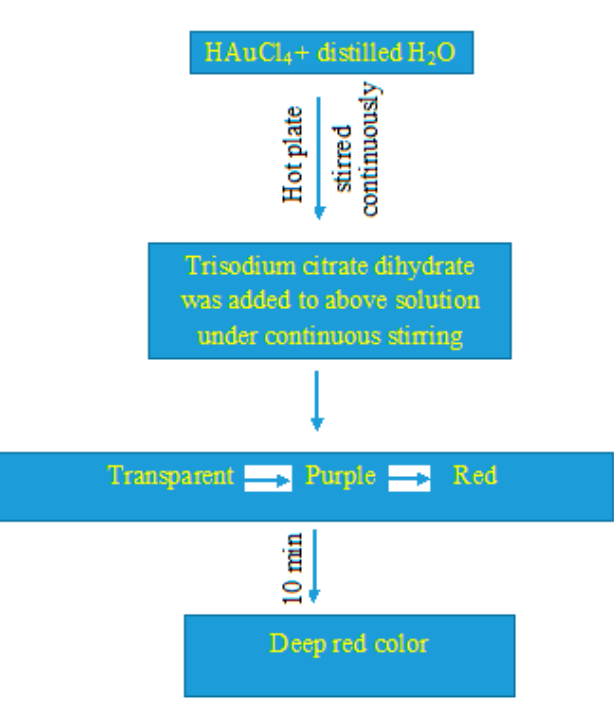
Figure 1. Schematic representation for synthesizing the gold nanoparticles (AuNPs). The method used to formulate AuNPs herein was easy and favored their synthesis without aggregation, in high yield and with low preparation cost. XRD analysis revealed peaks (2 θ ) at 38.18°, 44.39°, 64.57° and 77.54° (Figure 2).